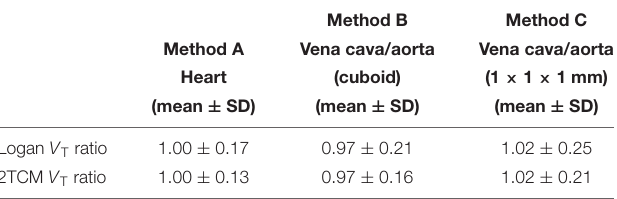
TABLE 2 | Mean V T ratios (IDIF/AIF) obtained from striatum, cortex, hippocampus, thalamus, cerebellum, hypothalamus, amygdala, olfactory bulb, and midbrain for each VOI related image-derived approach in both Logan graphical and 2TCM